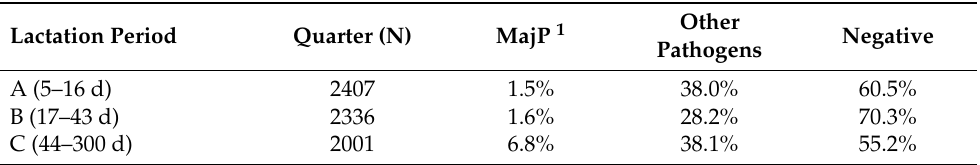
Table 2. Mammary gland health status: distribution of intramammary infections based on quarter milk sampling within the three lactational periods considered.